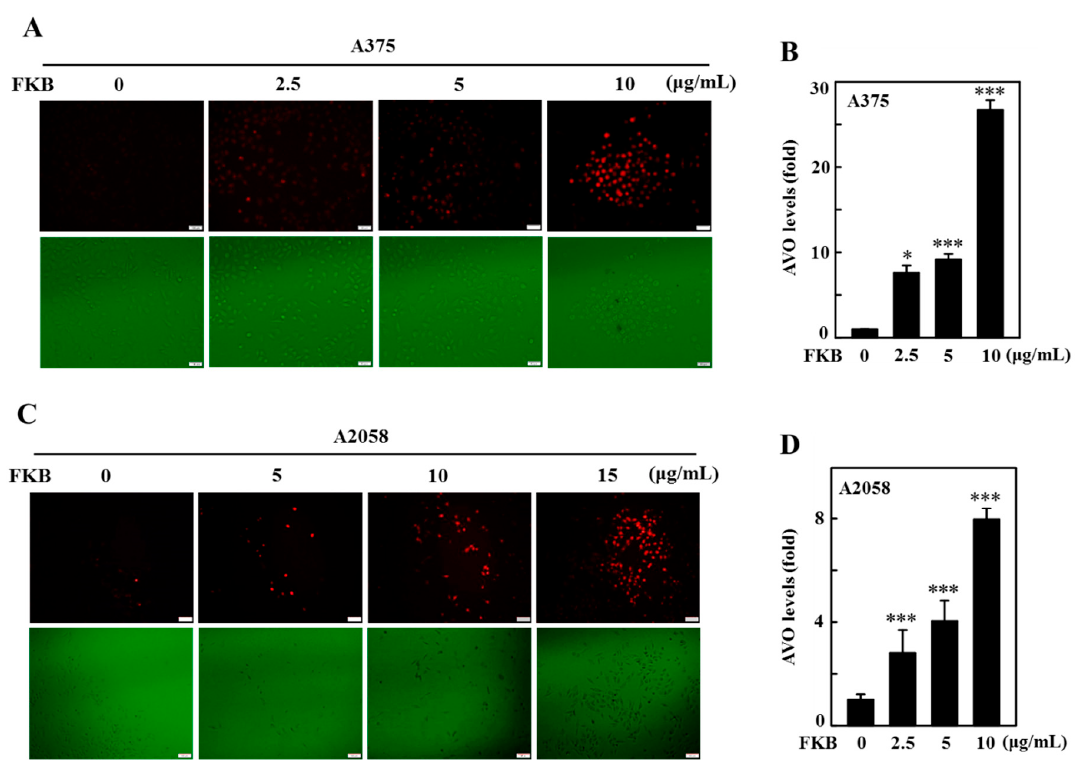
Figure 5. FKB triggered acidic vesicular organelle ( AVO) formation in A375 and A2058 cells. A375 and A2058 cells were exposed to different concentrations of FKB (0–10 or 0–15 µg/mL) for 24 h. Acridine orange stain was used to detect the AVOs formation that can be observed through a red filter fluorescence microscope (100× magnification). ( A , B ) Compared to the untreated control cells, FKB treatment dose-dependently significantly upregulated the formation of AVOs in A375 and ( C , D ) A2058 cells. Histogram depicting the number of acridine orange (AO) stained cells. The data were expressed as fold-over untreated control cells in which control was assigned as one. Each value was expressed as mean ± standard deviation (SD) of three experiments. Statistical significance was assigned as * p < 0.05, ** p < 0.01, and *** p < 0.001 as compared to untreated control